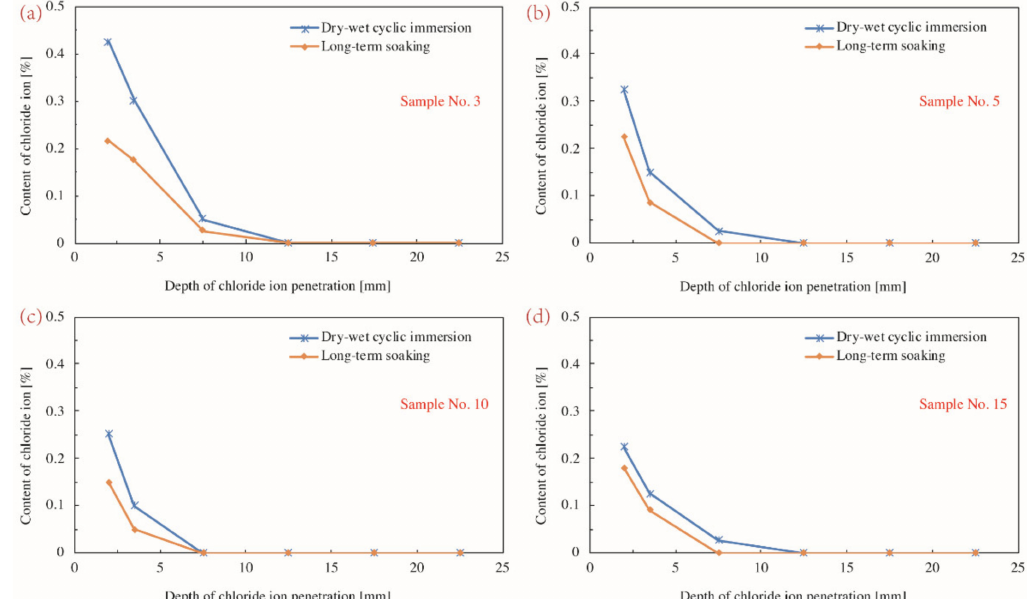
Figure 7. Depth of chloride ion penetration and the content of chloride ion in various depths of concrete samples corroded for 30 d: ( a ) Sample No.3; ( b ) Sample No.5; ( c ) Sample No. 10; ( d ) Sample No.